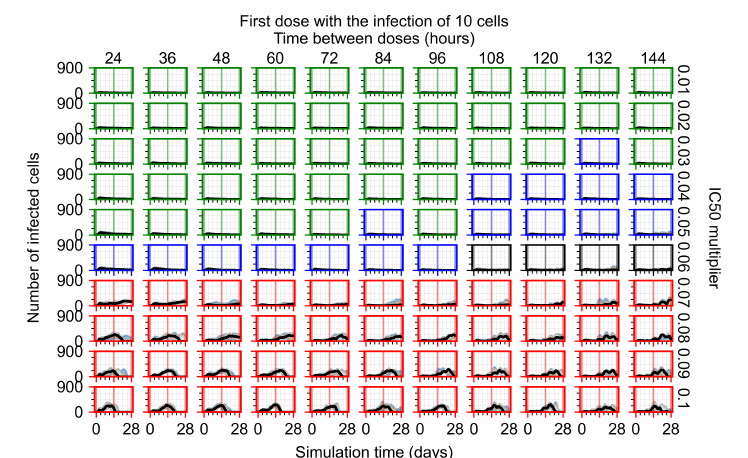
Figure A5. Uninfected population.